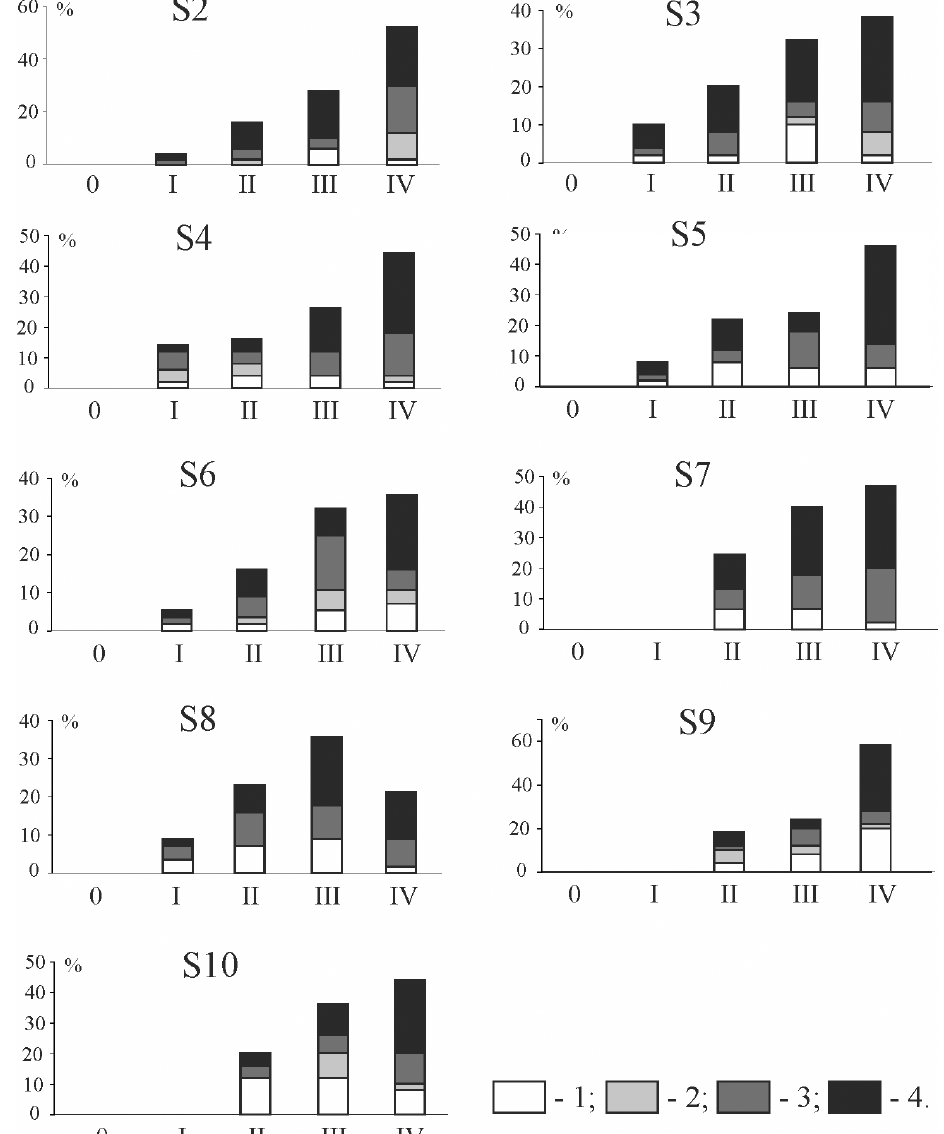
Figure A1. Distribution of quartz sand grains from section NS-6 by roundness and dullness. (1) Glossy; (2) quarter-matte; (3) half-matte; (4) matte; 0, I, II, III and IV are grades of roundness according to Khabakov